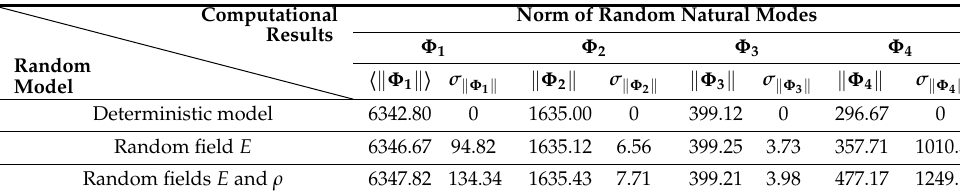
Figure 17. The distributions of lower bound ( left ), mean value ( middle ), and upper bound ( right ) of random natural modes when considering random fields E and ρ simultaneously. Table 2. Comparison of the norm of natural modes for different random models. Computational